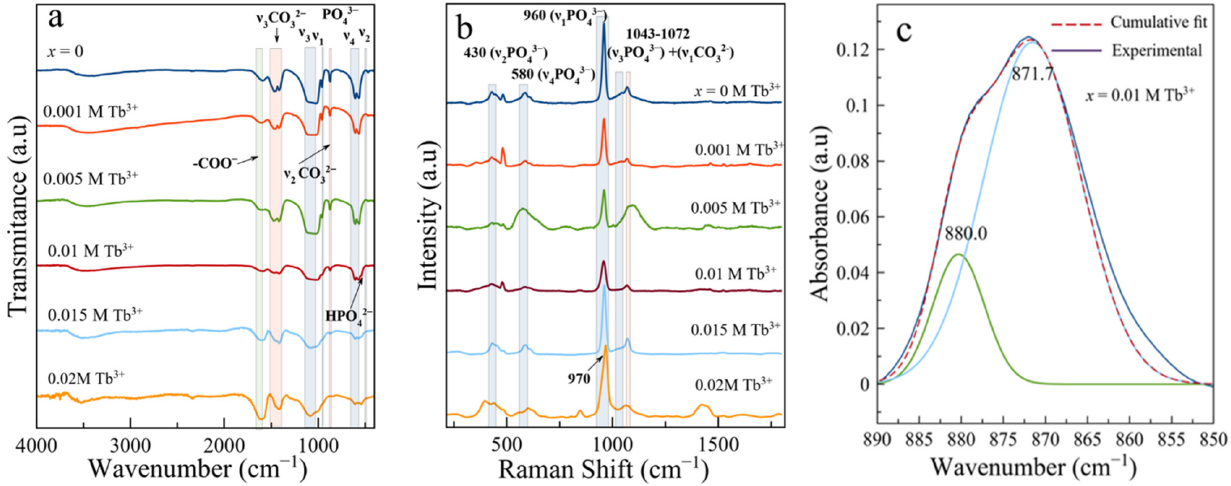
Figure 3. ( a ) FTIR and ( b ) Raman spectra of samples at 96 h maturation varying x (from 0 to 0.02